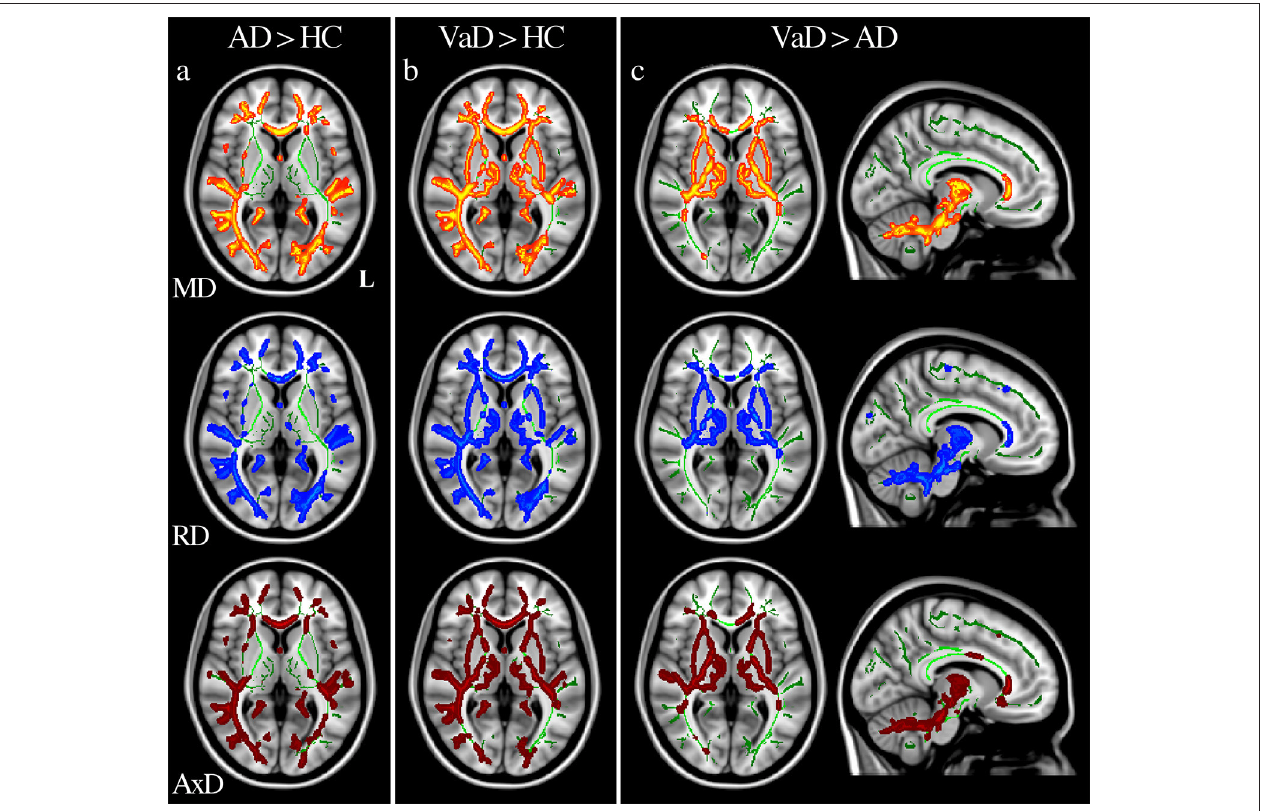
FIGURE 2 | Diffusivity alterations in patients. Significance was set at p < 0.01 TFCE corrected for multiple comparisons. All results are overlaid onto the MNI 152 template. Axial slices correspond to z = 4mm while sagittal slices correspond to x = − 9mm. L = left hemisphere. Increases of MD (top row), RD (middle row), and AxD (bottom row) are reported in: (a) AD vs. HC, (b) VaD vs. HC, (c) VaD vs.